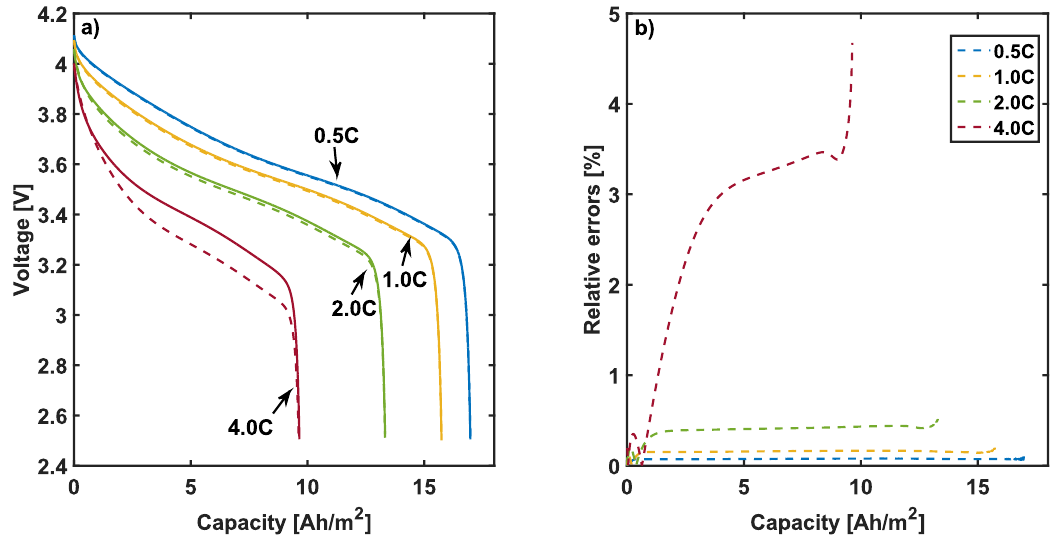
Figure 4. ( a ) Comparison of voltage-discharge curves of the ESM (- - dashed line) and P2D model (– solid line) at a constant temperature of 25 ◦ C, and 0.5C, 1.0C 2.0C and 4.0C; ( b ) Relative errors of voltage-discharge curves. All electrochemical parameters for numerical validation are listed in